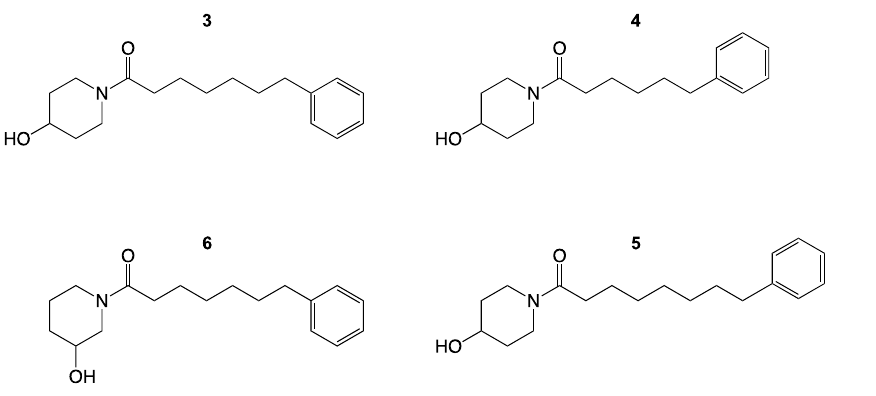
Figure 4. Piperidine analogs create a novel mitofusin activator scaffold. Table 2. Functional and pharmacokinetic properties of piperidine variants.